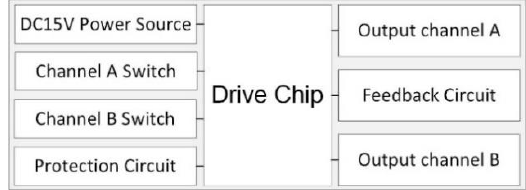
Figure 12. Schematic diagram of the IGBT drive circuit.